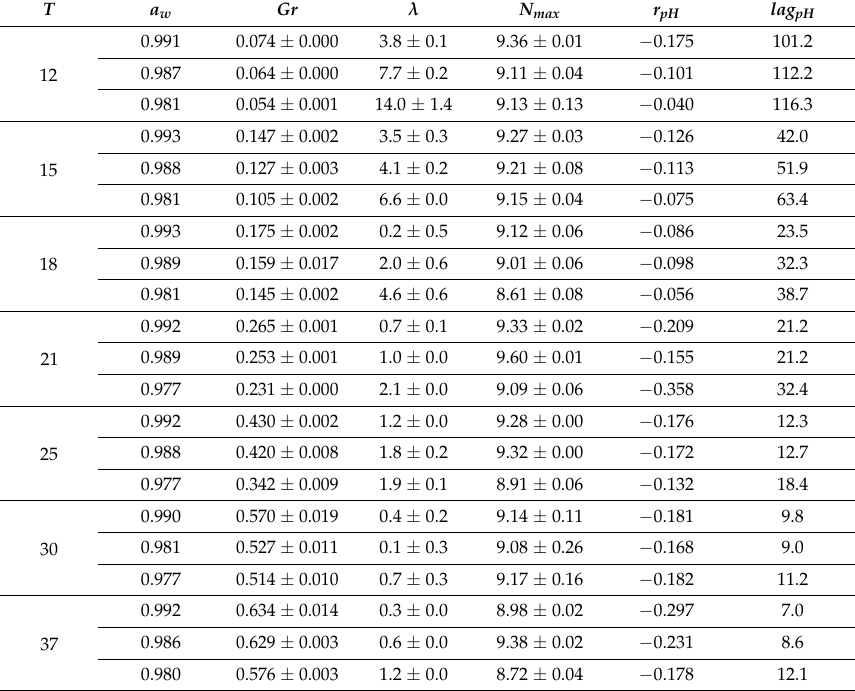
Table 2. The effect of temperature and water activity on the growth and metabolic activity of Fresco culture in